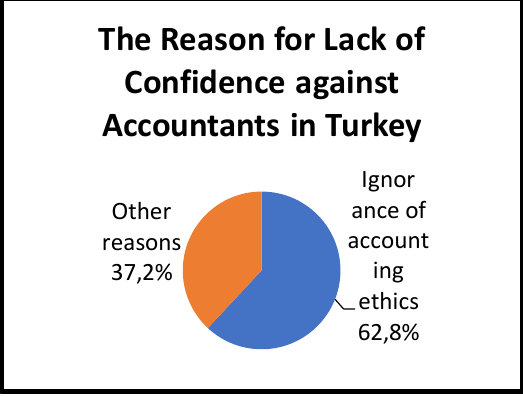
Figure 7. The Reason for Lack of Confidence against